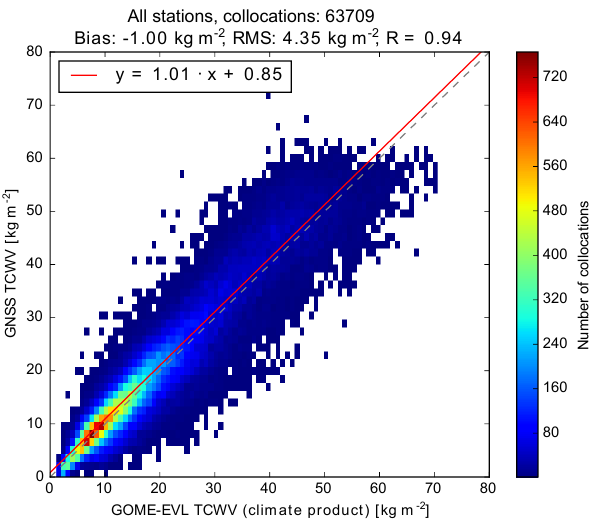
Figure 11. Scatter plot of TCWV monthly means of all available GNSS stations and the climate product. Figure from Danielczok and Schröder (2017).